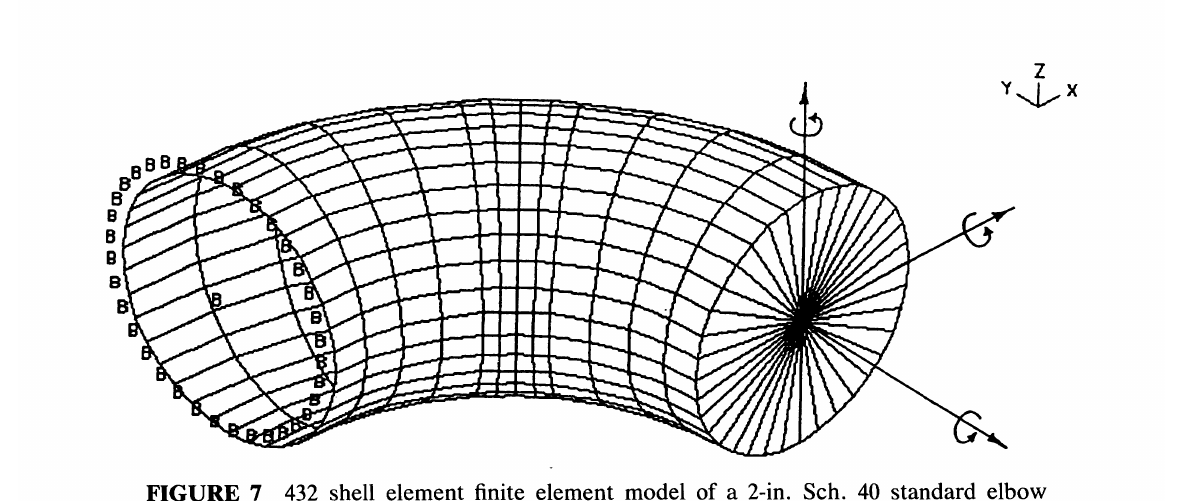
FIGURE 7 432 shell element finite element model of a 2-in. Sch. 40 standard elbow subject to 6-dimensional prescribed displacement time